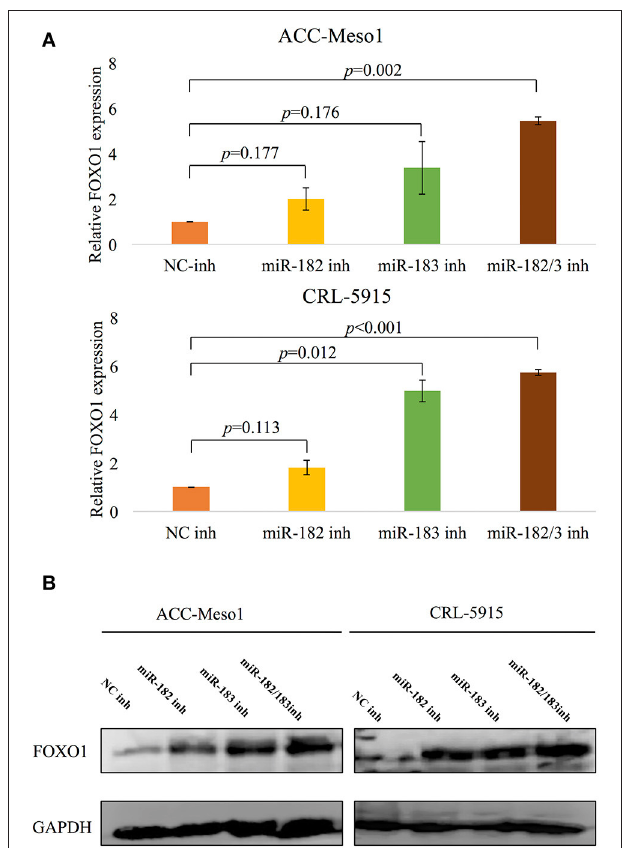
FIGURE 3 | (A) RT-PCR analysis shows upregulation of FOXO1 mRNA expression following treatment with miR-182 or miR-183 inhibitor. Inhibition of both miR-182 and miR-183 lead to even more upregulation of FOXO1. (B) Results of western blot analysis showing upregulation of FOXO1 protein expression following treatment with inhibitors of miR-182, miR-183, or a combination of both miRNAs.